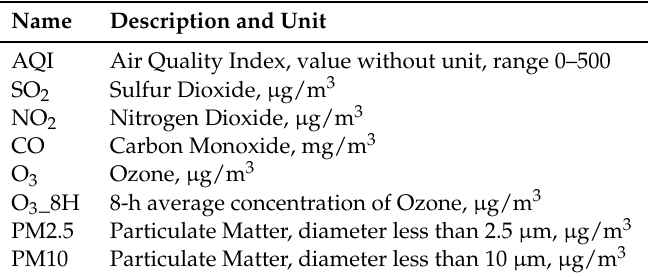
Table 1. Reported air index and pollutants and their descriptions.